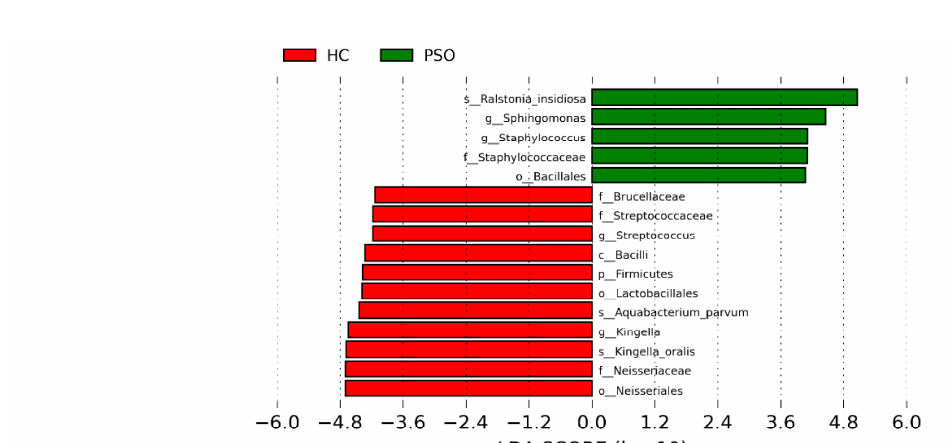
Figure 5. Analysis of species diversity between the two groups. Cladistic map of microbial evolution ( A ); histogram of LDA value distribution ( B ). In the evolutionary branching diagram, circles radiating from the inside out indicate taxonomic levels from phylum to genus (or species). Each small circle for a different taxon class represents the taxa of that class, and the diameter of the small circle is proportional to the relative abundance. The species with no significant differences are yellow, with red nodes representing the microbiota playing an important role in the control group and green nodes representing the microbiota playing an important role in the PSO group. The length of the histogram indicates the size of the impact of different species (LDA score) (HC: healthy control group; PSO: psoriasis